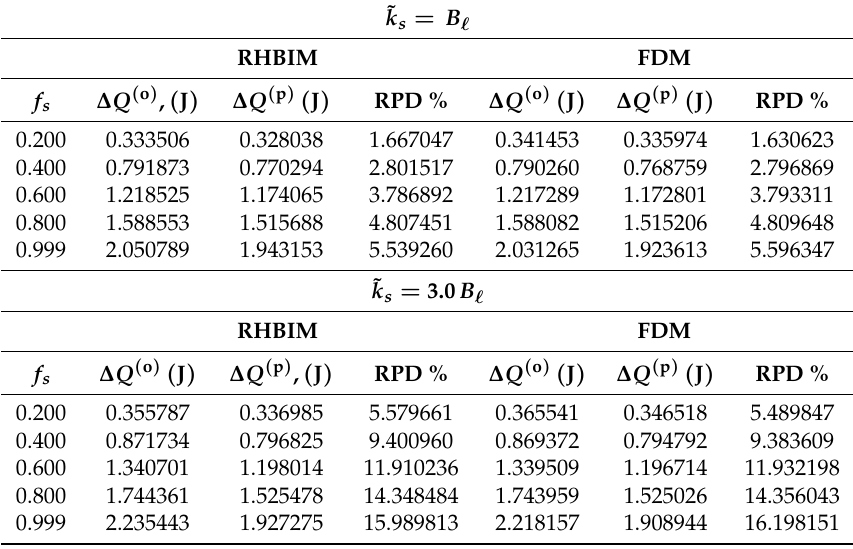
Table 3. Calculated values of ∆ Q for ˜ k s = B (cid:96) and ˜ k s = 3 B (cid:96)